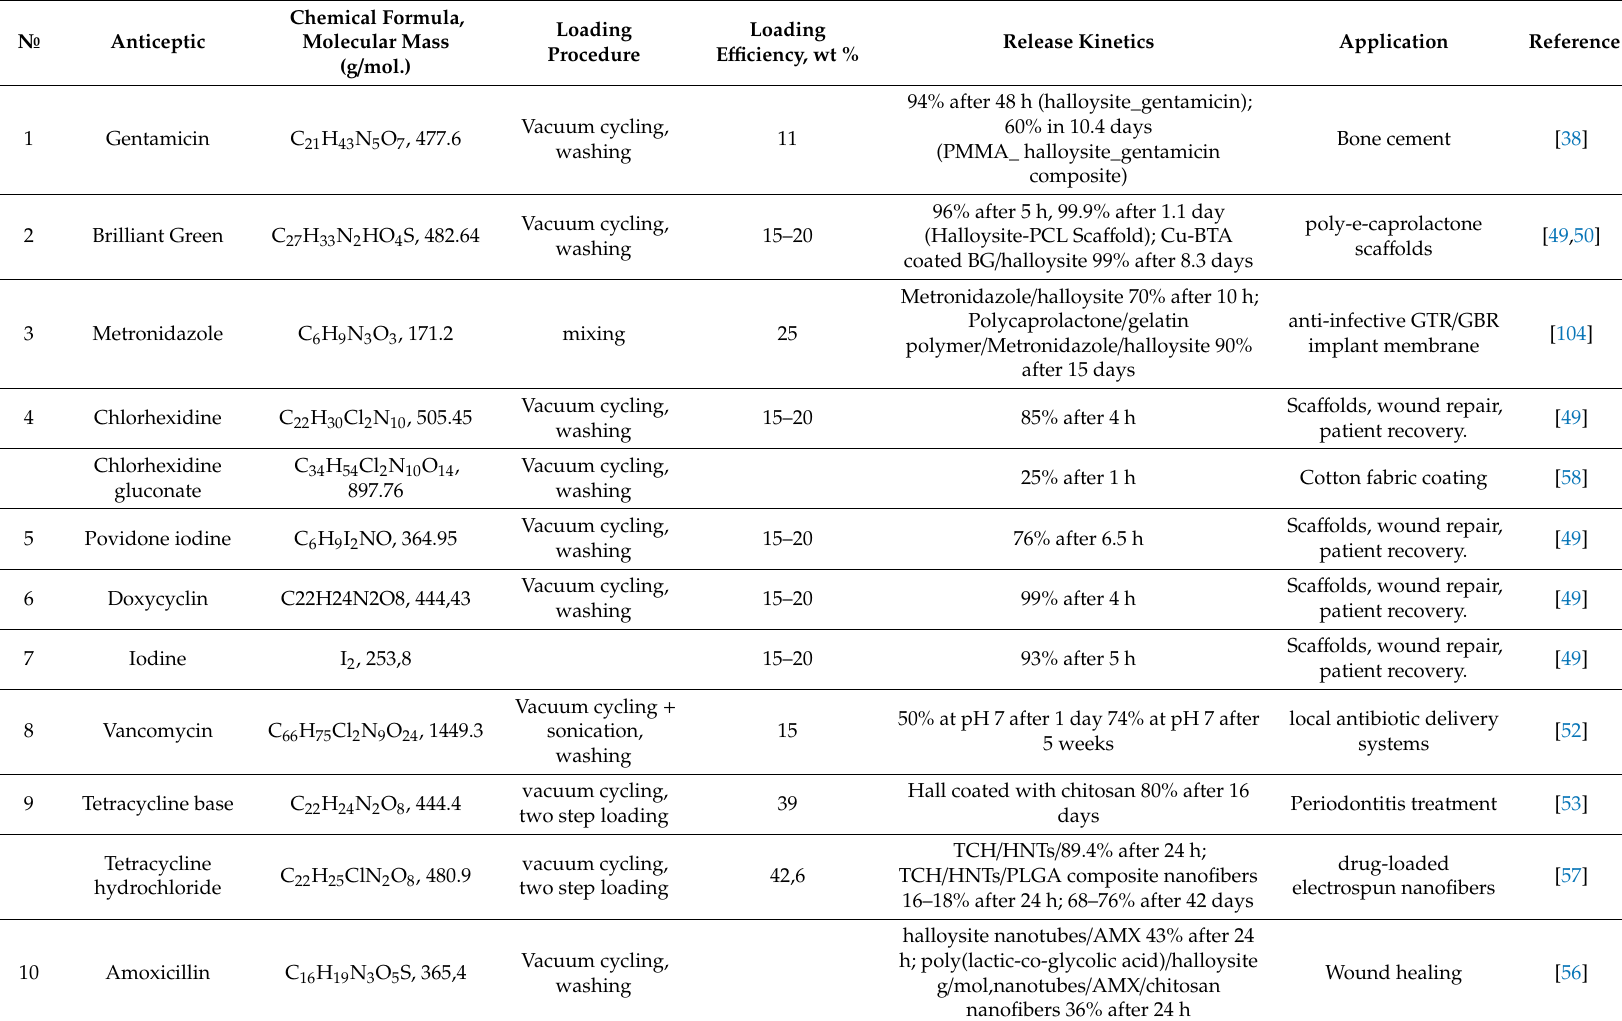
Table 1. Loading e ffi ciency and release kinetics of organic antibacterial agents loaded inside halloysite